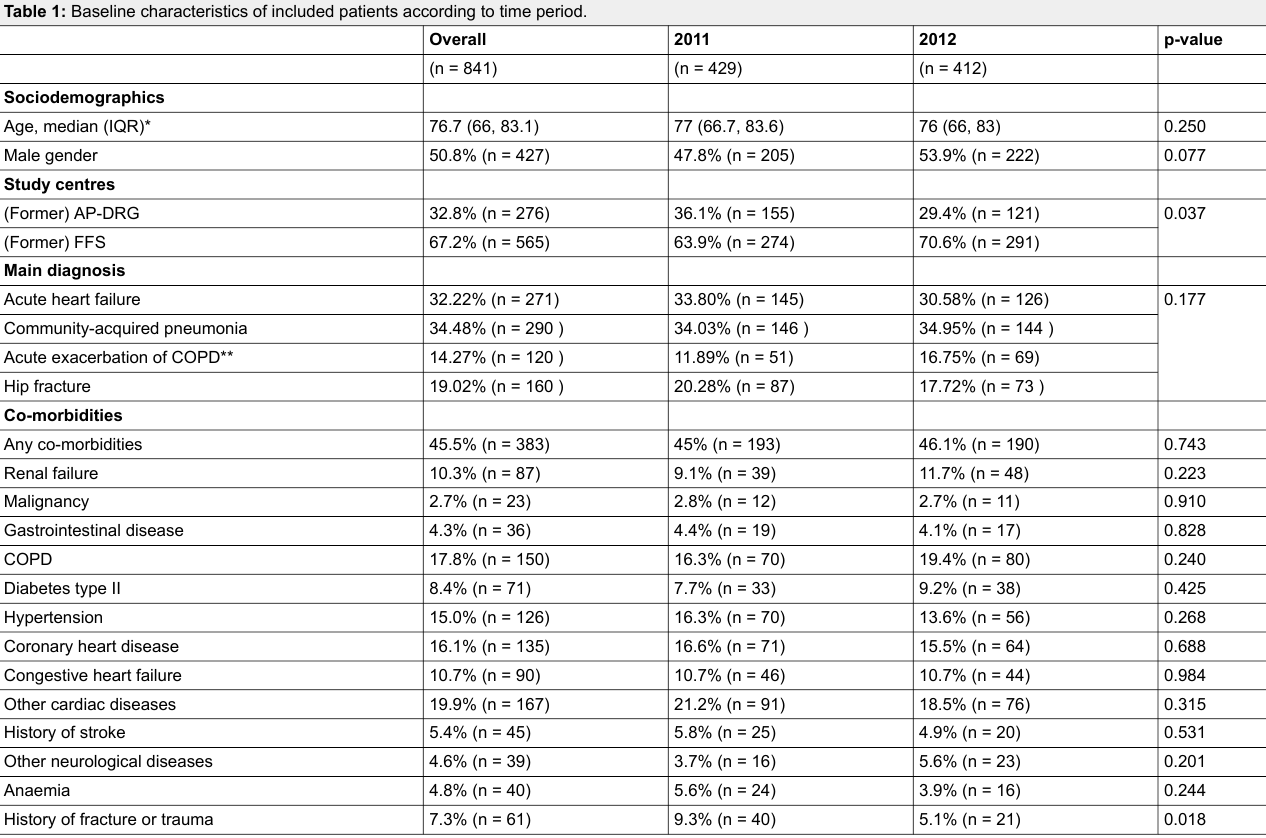
Table 1: Baseline characteristics of included patients according to time